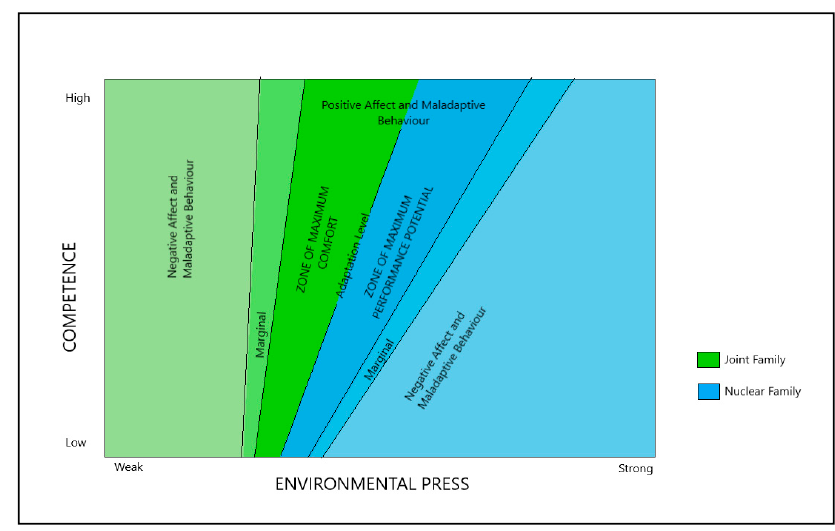
Figure 6. Adaption of the Ecology Model of Aging (Lawton and Nahemow 1973).